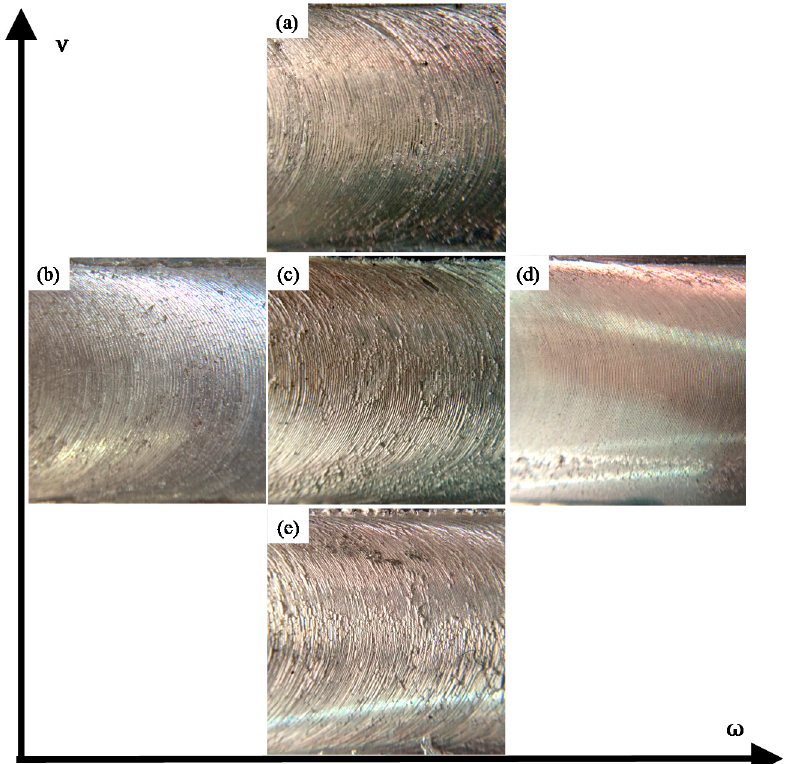
Figure 4. Repaired specimen surfaces. ( a ) S1100 V150, ( b ) S700 V110, ( c ) S1100 V110, ( d ) S1500 V110, ( e ) S1100 V90.